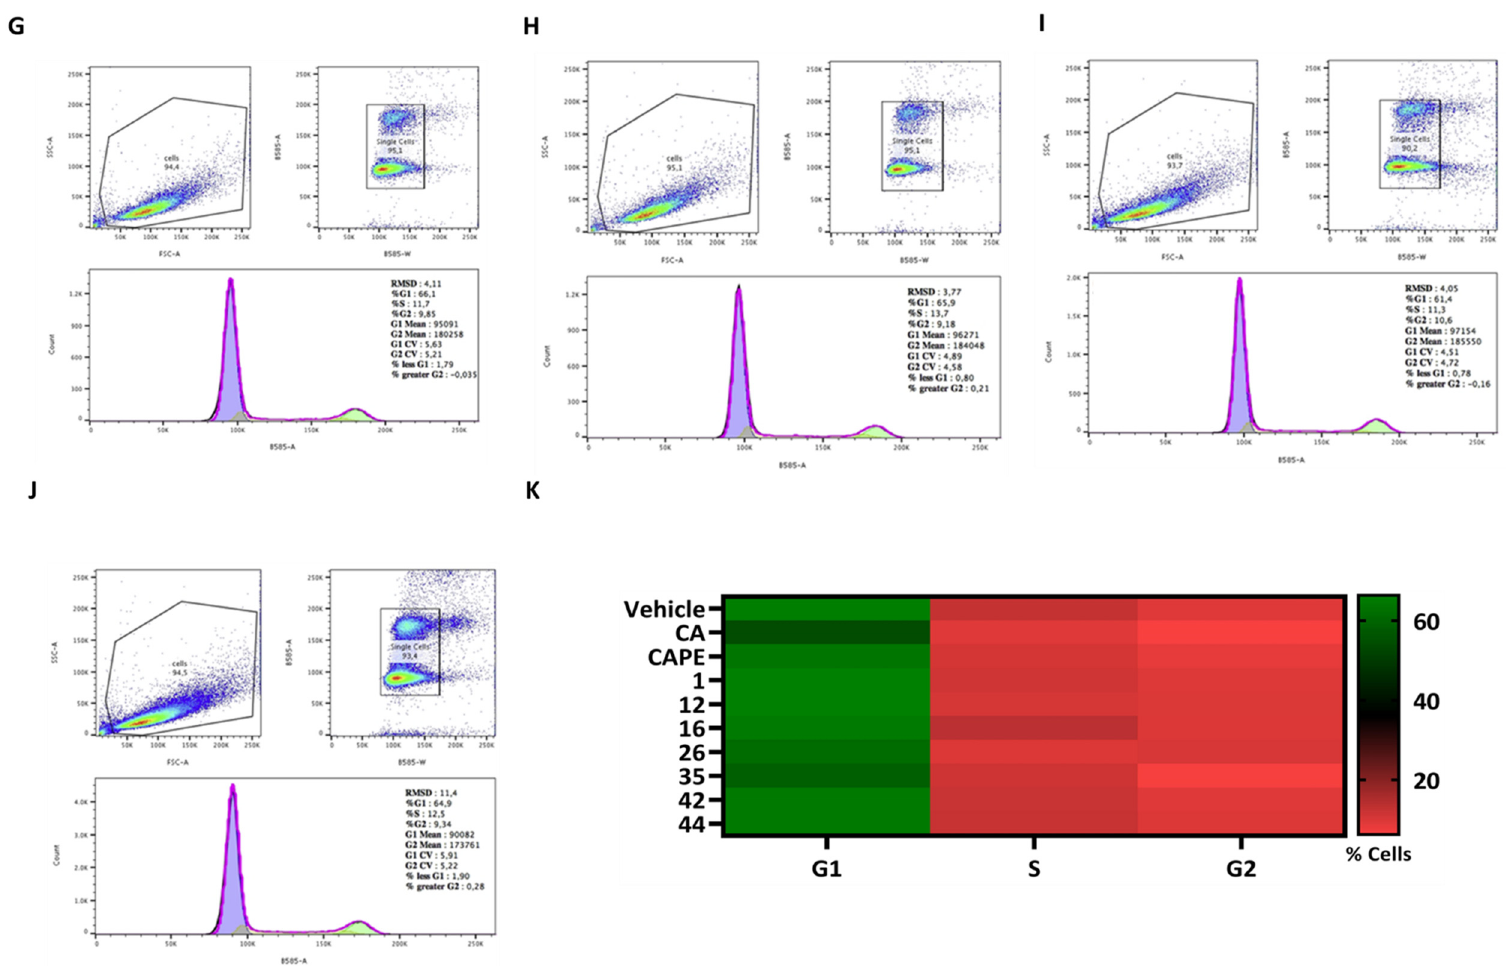
Figure 3. The impact of Caffeic acid and CAPE analogs on the cell cycle as the toxicity indicator. The 293T cells were pre-treated with 10 µ M of the selected compounds for 24 h and the cell cycle was analyzed using propidium iodide ( A ) Vehicle, ( B – J ) impact of CA and CAPE pre-treatment on AAPH induced oxidative insult, and ( K ) the graphical representation of the trend in the cell cycle of 293T cells in response to different treatments.